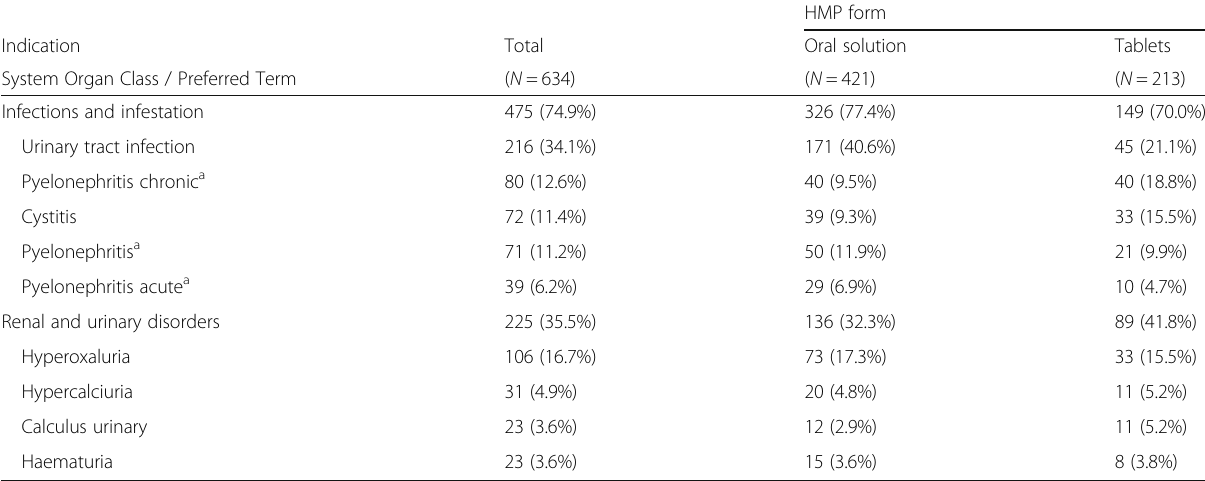
Table 3 Treatment indications (> 3%) (Safety